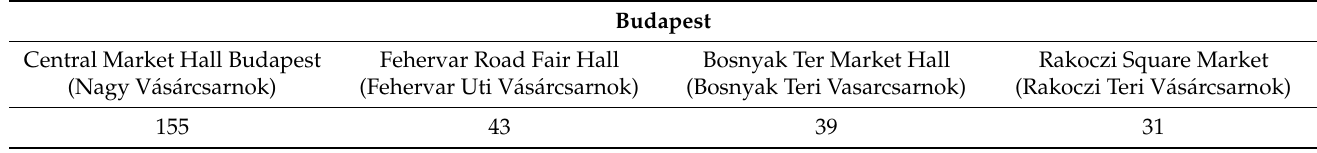
Table 1. Questionnaire spread number based on